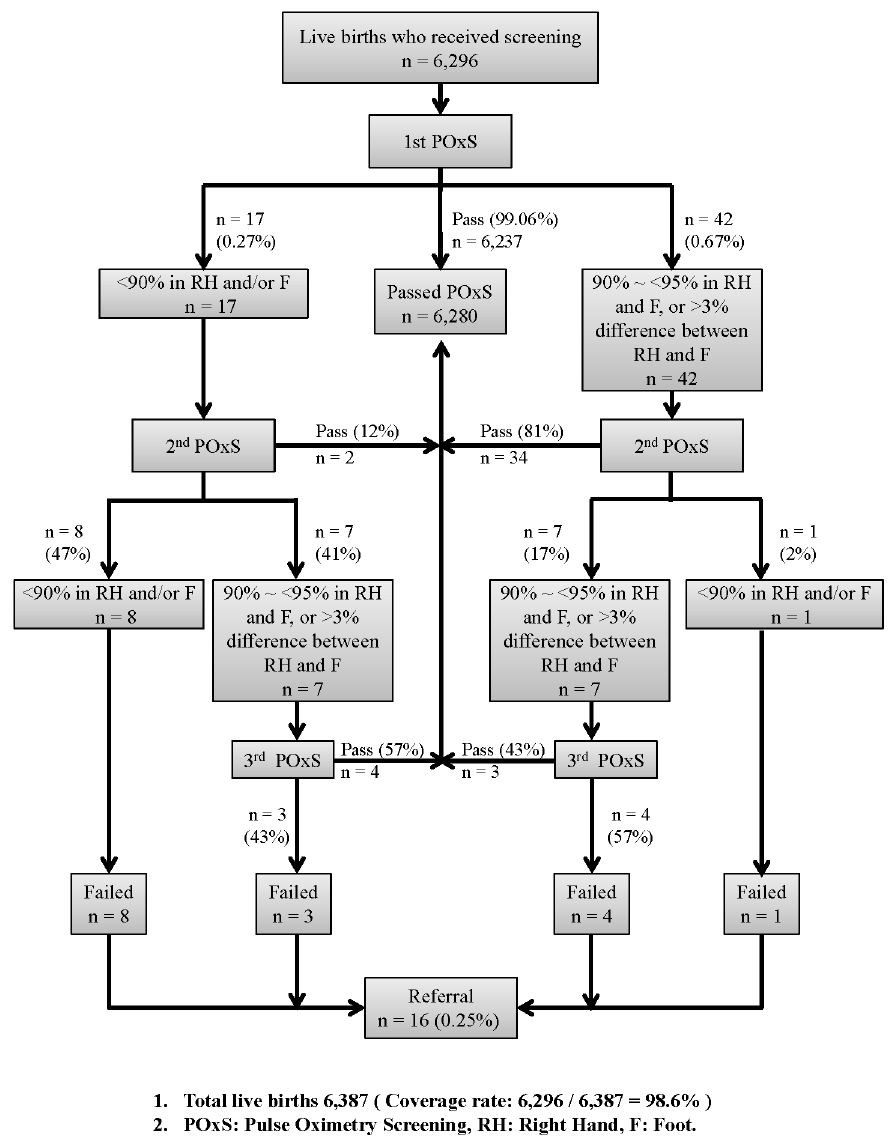
Fig 2. Aggregate pulse oximetry screening results from the 12 birthing facilities for live births. Total live births: 6,387 (coverage rate: 6,296/6,387 = 98.6%). Abbreviations: pulse oximetry saturation, POxS; right hand, RH; foot,